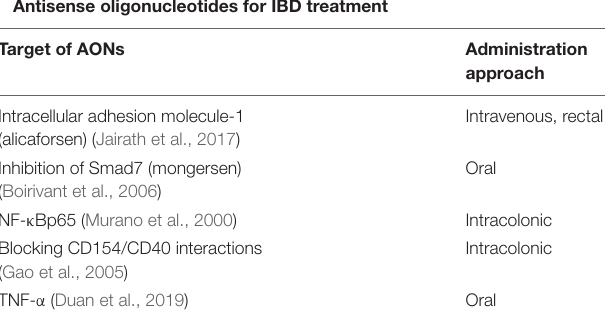
TABLE 3 | Antisense oligonucleotides in IBD